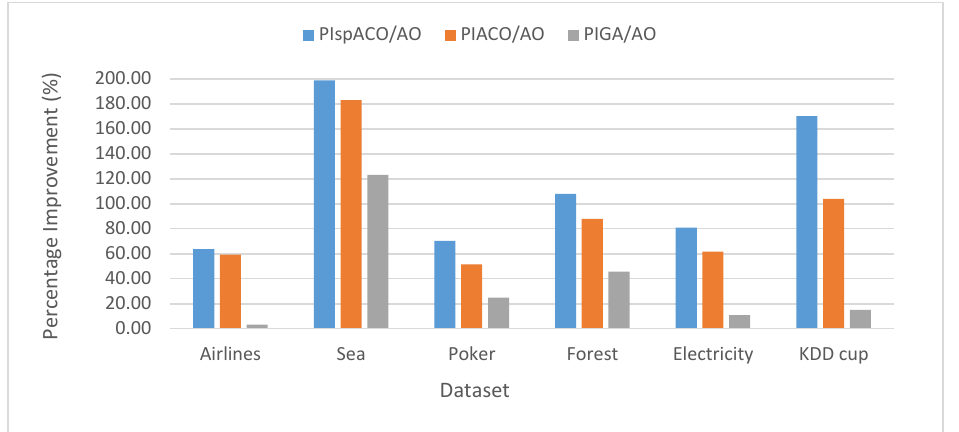
Figure 2. Analysis of PI for SC in different algorithms over IT2FCM-AO.